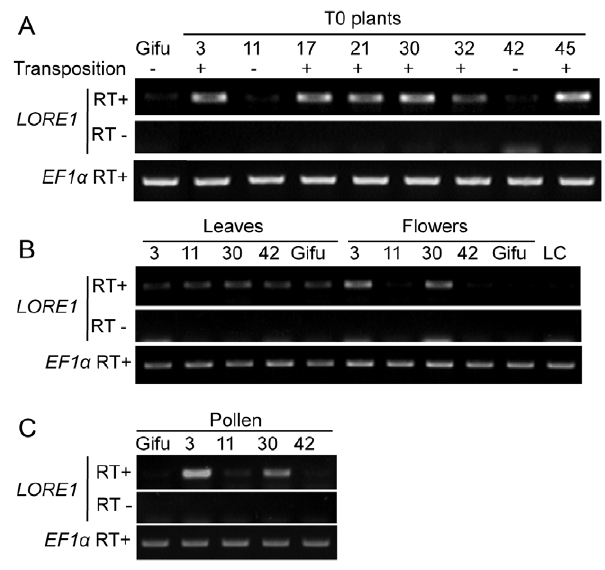
Figure 2. Correlation between transcription level and transpo- sitional activity of LORE1 . (A) LORE1 transcript levels in T0 plant nos. 3, 11, 17, 21, 30, 32, 42, and 45, as well as in a control Gifu plant. Plants marked with + show transpositional activity of LORE1 , those marked with–do not. The upper panel (RT + ) shows an image of an RT-PCR of LORE1 transcripts in flowers. The middle panel (RT 2 ) shows negative control reactions without reverse transcriptase. The equal abundance of RNA among samples was confirmed by RT–PCR detection of elongation factor 1 alpha transcripts ( EF1 a ). (B) LORE1 transcript levels among T0 plants vary in flowers, but not in leaves. The levels of LORE1 transcripts in flowers and leaves were determined by RT–PCR as in (A) using RNA samples extracted from four T0 plants, two with LORE1 activity (nos. 3 and 30) and two without LORE1 activity (nos. 11 and 42), together with a control Gifu plant and liquid-cultured cells (LC) from a Gifu plant. Images from a negative control experiment (RT 2 ) and a control, to demonstrate equal abundance of RNA ( EF1 a ), are also presented. (C) Transcriptional activation of LORE1 in pollen. Transcript levels in mature pollen grains isolated from LORE1 -activated T0 plants (3 and 30), T0 plants without LORE1 activity (11 and 42), and control Gifu plants, were compared by RT–PCR. Images of a negative control experiment (RT 2 ) and a control, to demonstrate equal abundance of RNA ( EF1 a ), are also